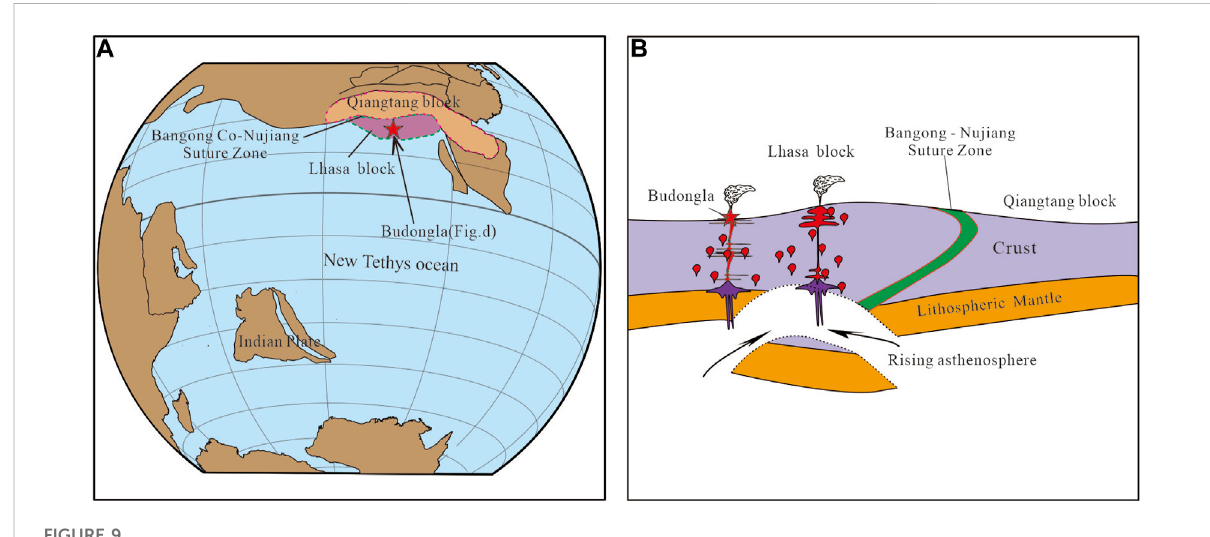
FIGURE 9 Schematicillustrations of theLate Cretaceous tectono-magmatic evolution of theQiangtang-Lhasaterrane.[ (A) ,Basemap after Ma etal., 2014 (B) , Basemap after Zhu et al.,